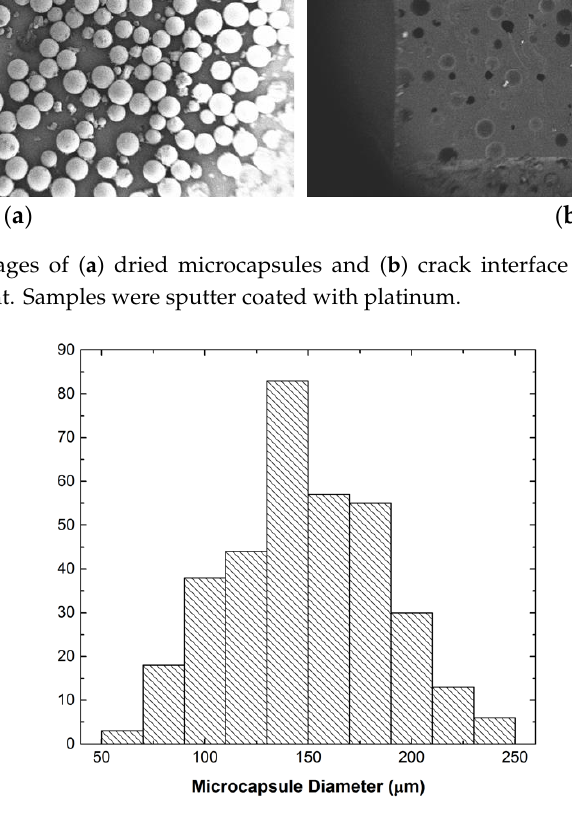
Figure 3. Size distribution of microcapsules filled with PA and MMI-2 healing agent.